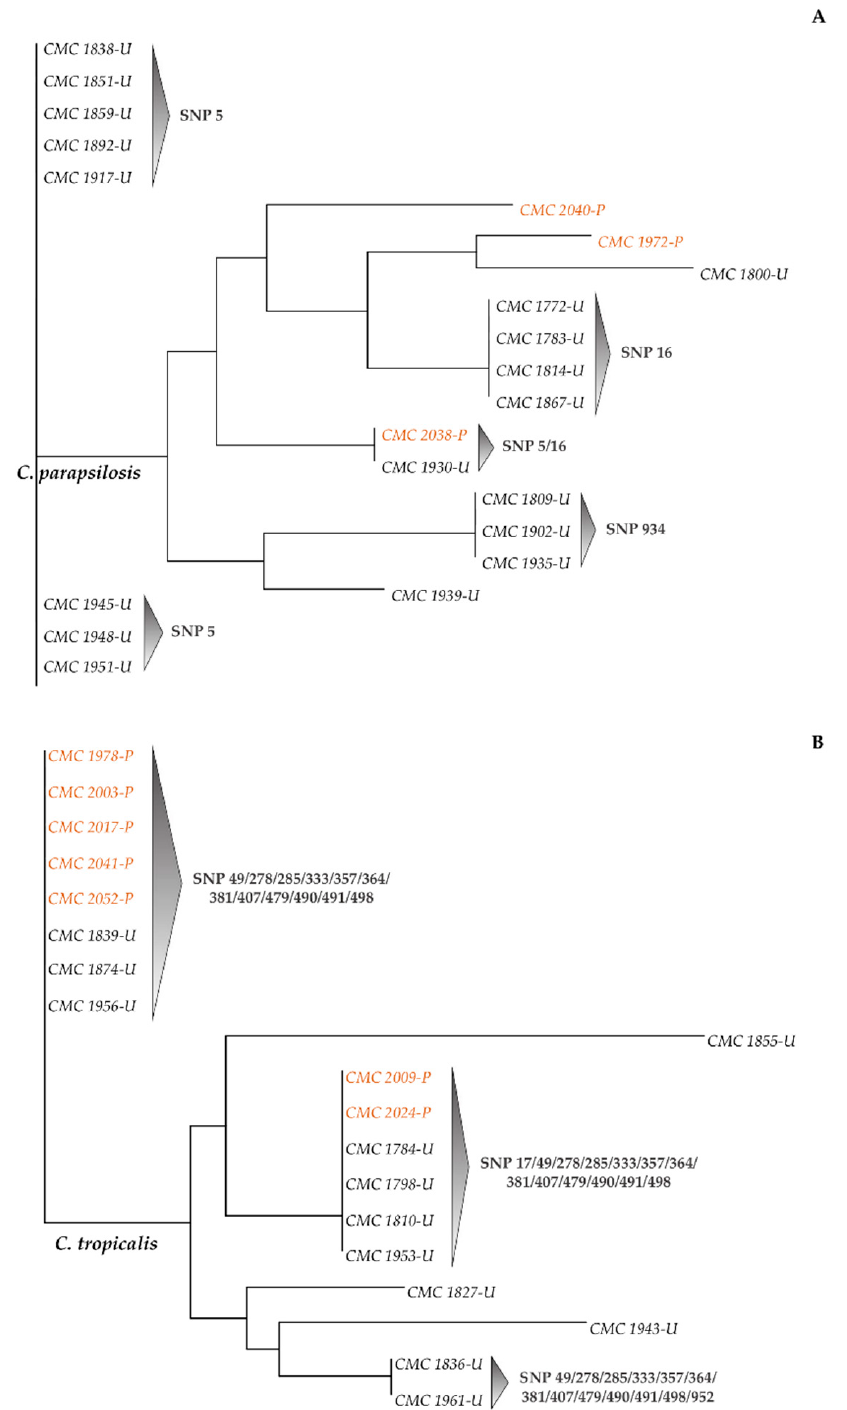
Figure 9. Neighbor-joining phylogenetic trees of the C. parapsilosis and C. tropicalis strain sets. ( A ) C. parapsilosis neighbor-joining phylogenetic tree; ( B ) C. tropicalis neighbor-joining phylogenetic tree. Black plain characters: Udine Hospital; orange plain characters: Pisa Hospital.